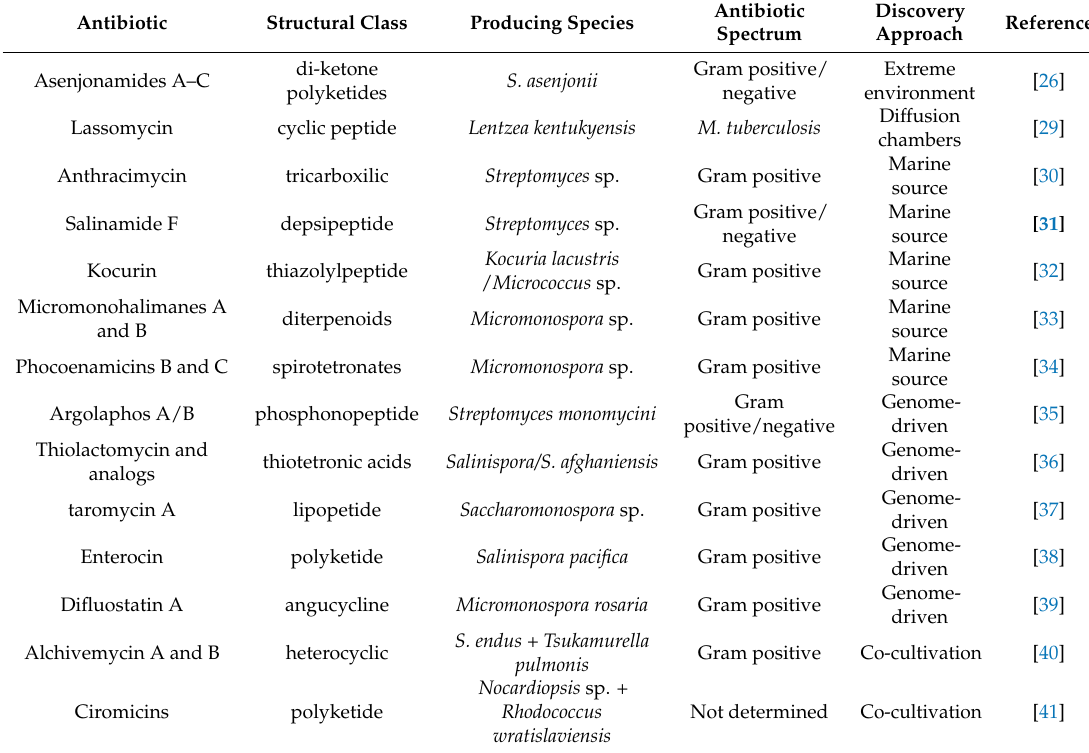
Table 1. New antibiotics and analogs described from Actinomycetes since 2013, following different mining